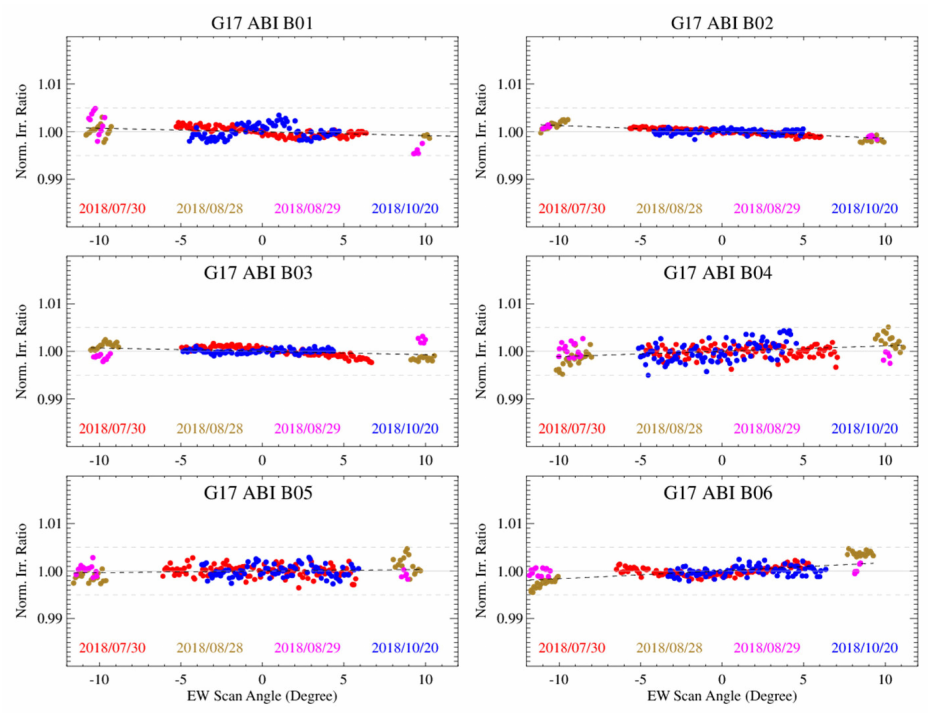
Figure 19. Same as Figure 18, but for G17.